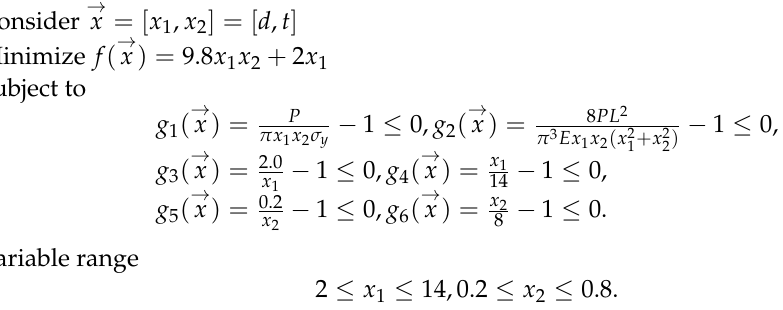
Figure 13. Schematic illustration of tubular column design